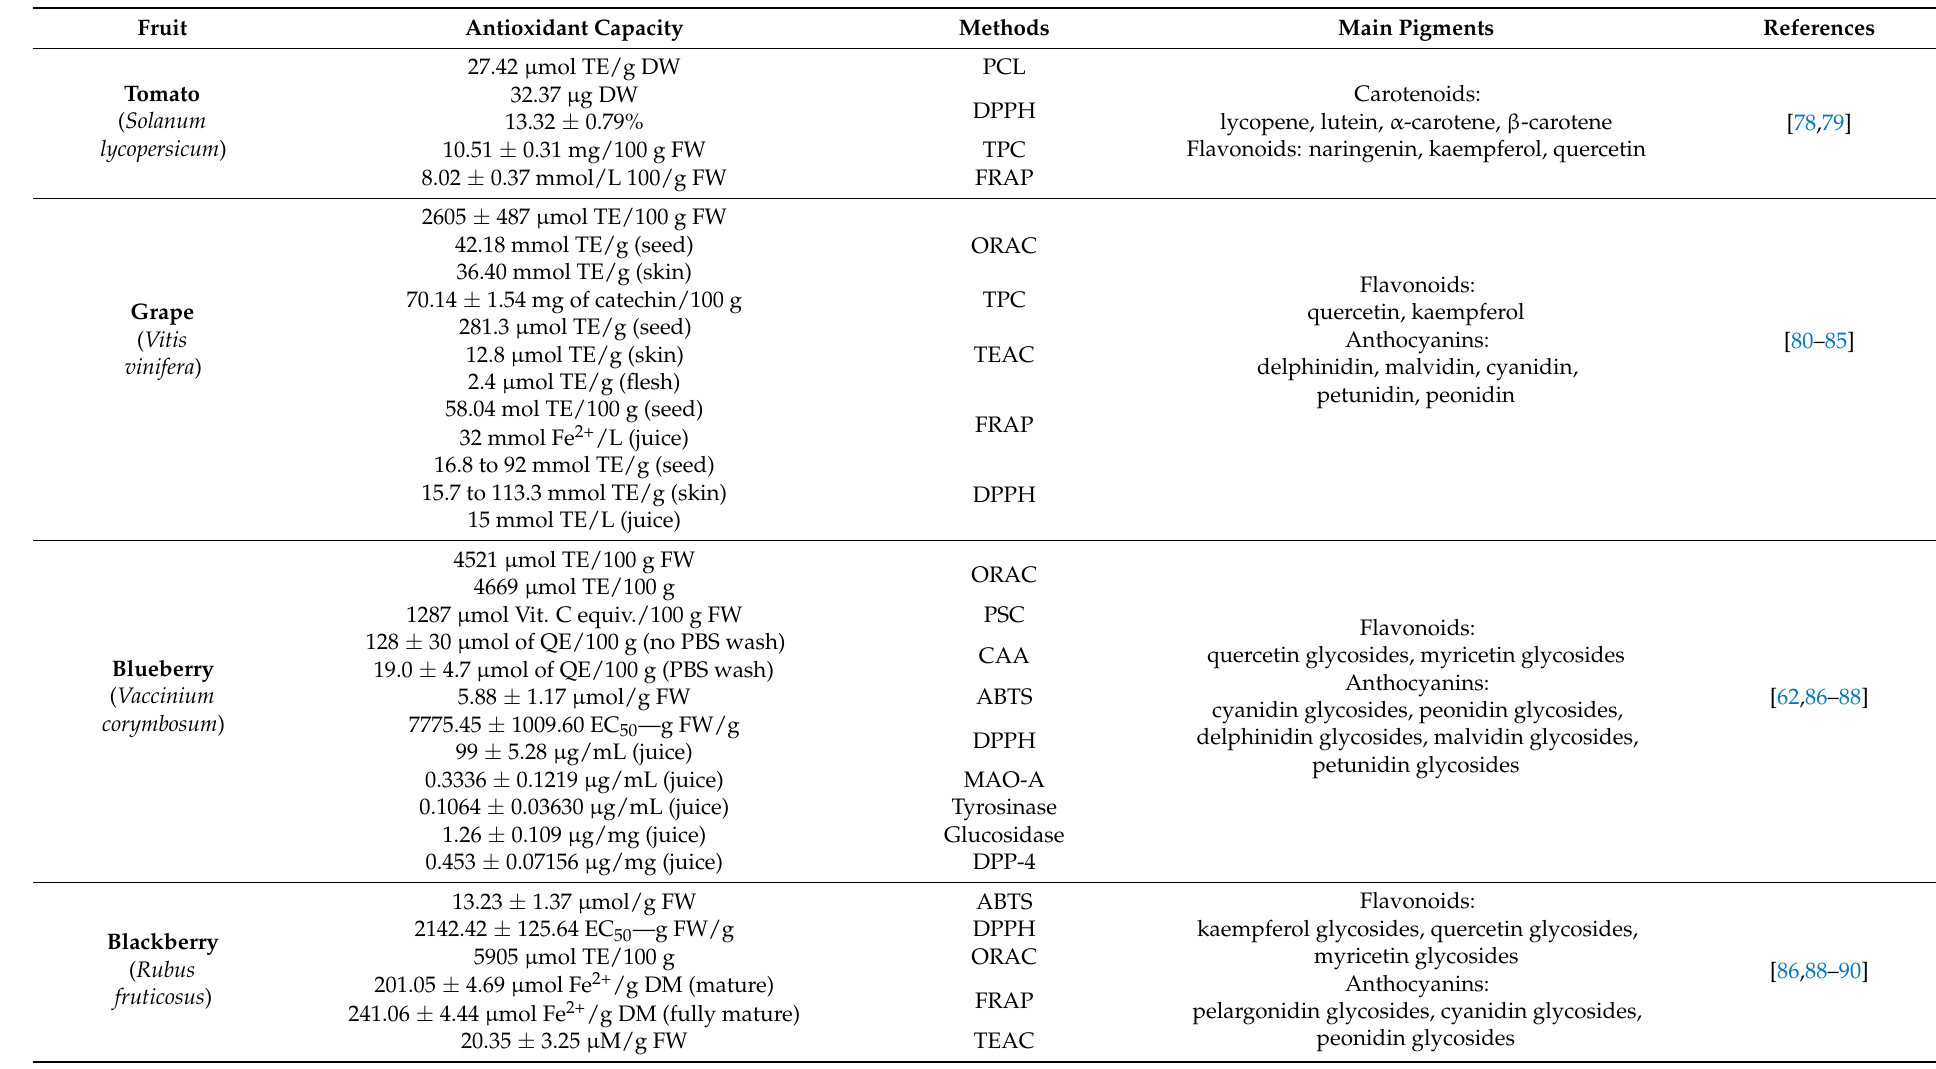
Table 1. The antioxidant capacity and main antioxidant pigments of common